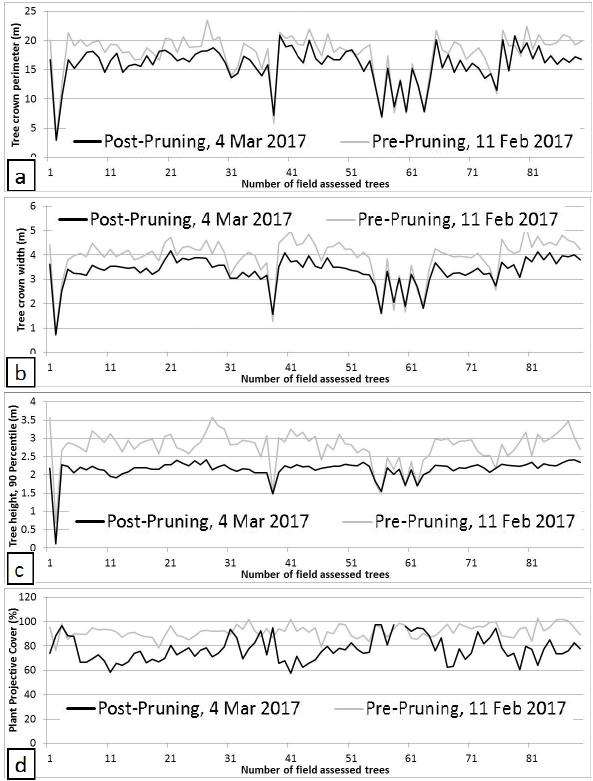
Figure 7. Pre- and post-pruning differences for the 89 field assessed lychee trees in (a) tree crown circumference, (b) tree crown width, (c) 90 percentile tree crown height, and (d) PPC measured from the RPAS imagery collected at 30 m